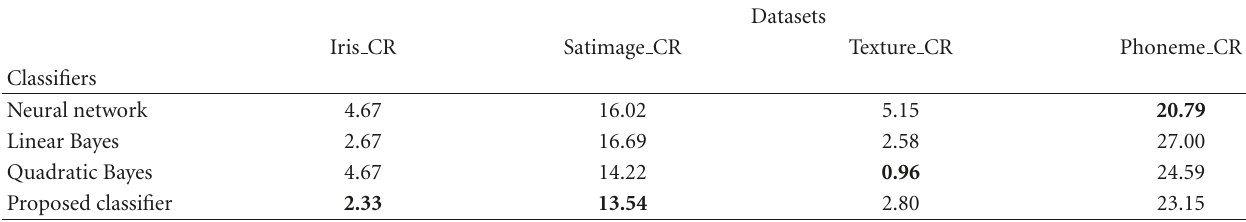
Table 3: Error rates in percentage for conventional and proposed classifiers on several datasets. The best results are highlighted in boldface.